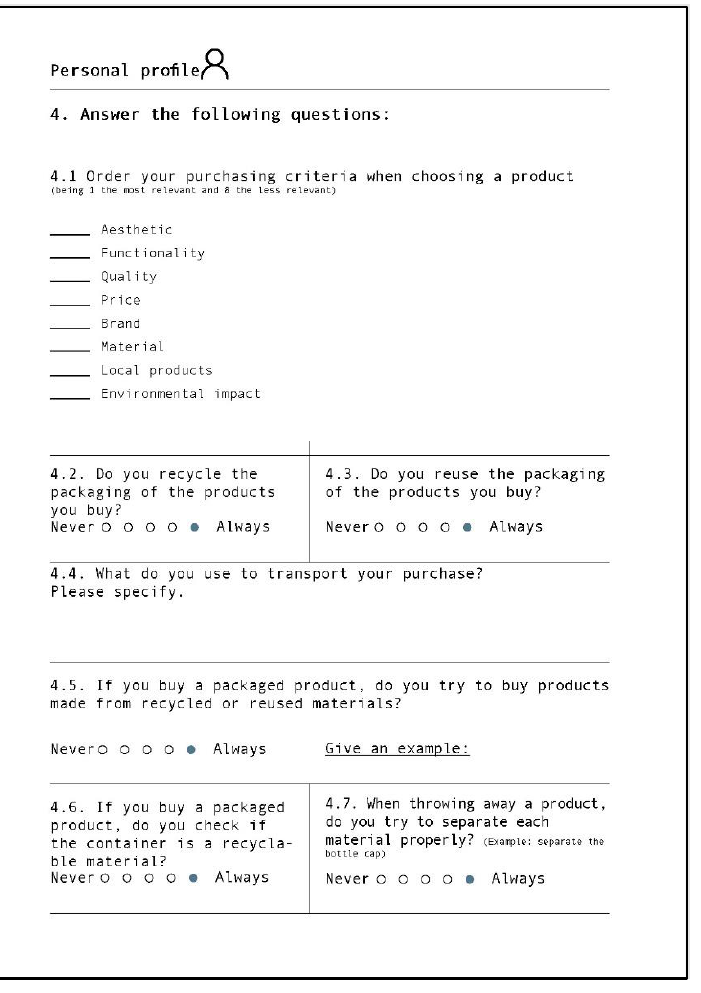
Figure 7. Consumption habits questionnaire. Blue circles show the answers that are associated with better consumption habits.